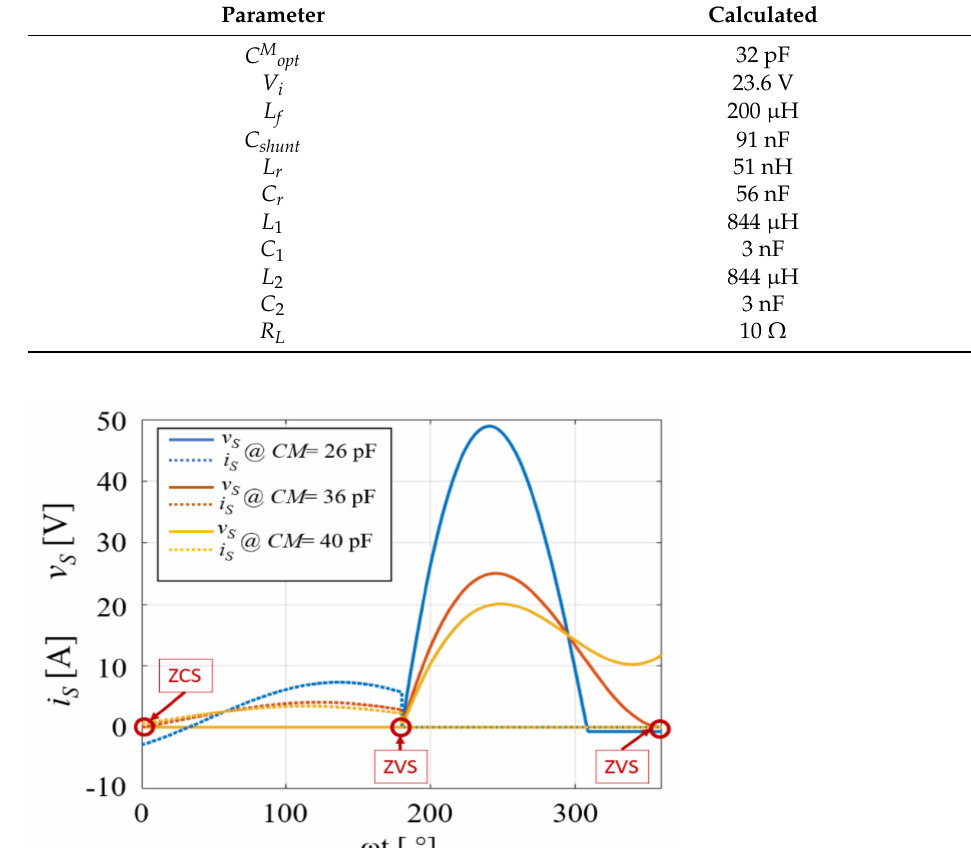
Table 1. Component values for the designed system.